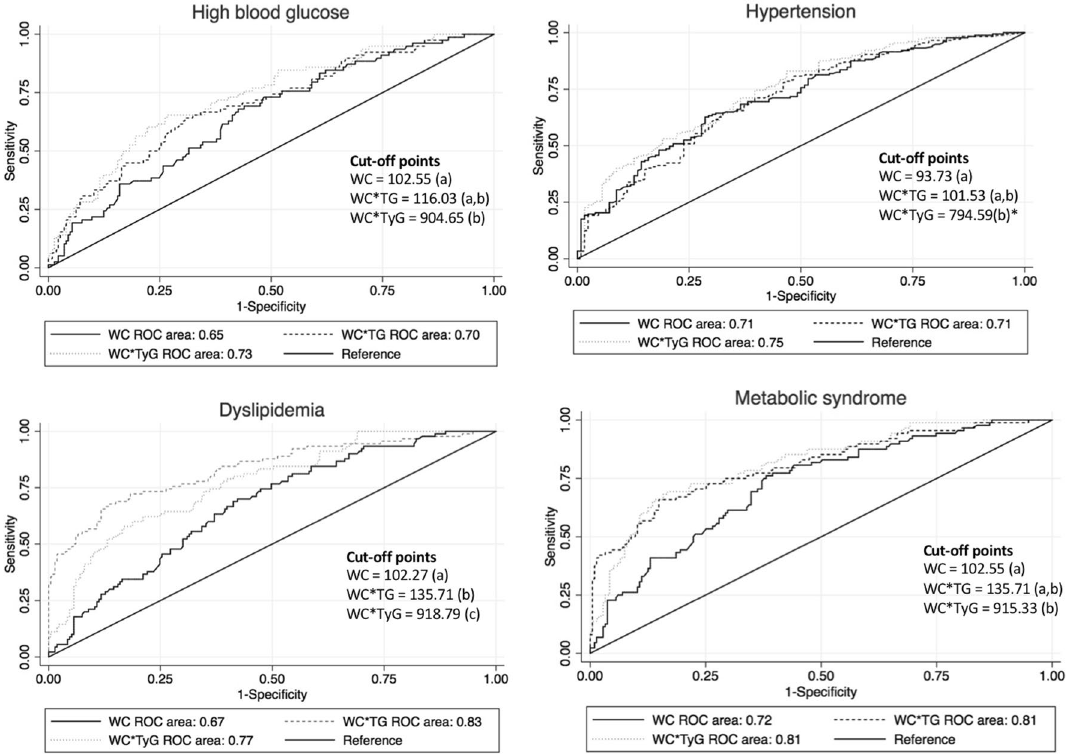
Figure 1. Receiver operating characteristic (ROC) curve analysis for each index (waist circumference, waist circumference-triglycerides, waist circumference-TyG). The different indices were classified in the same